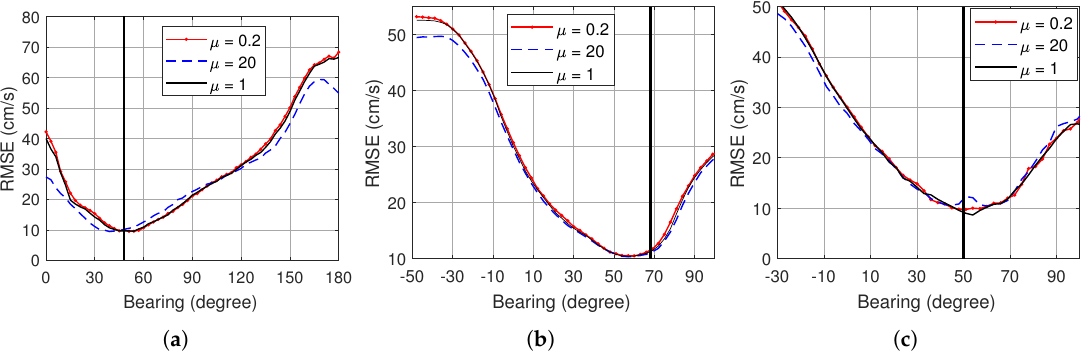
Figure 15. Root-mean-square error (rmse) varying with the bearing for radar–buoy comparison. ( a ) DOSH–buoy comparison; ( b ) SHLI–buoy A comparison; ( c ) SHLI–buoy B comparison. µ is the constant imposed on the cosine and sine loops, and µ = 1 is the normal TLSCR calibration, which is also shown in Figure 11. The vertical line indicates the bearing of the